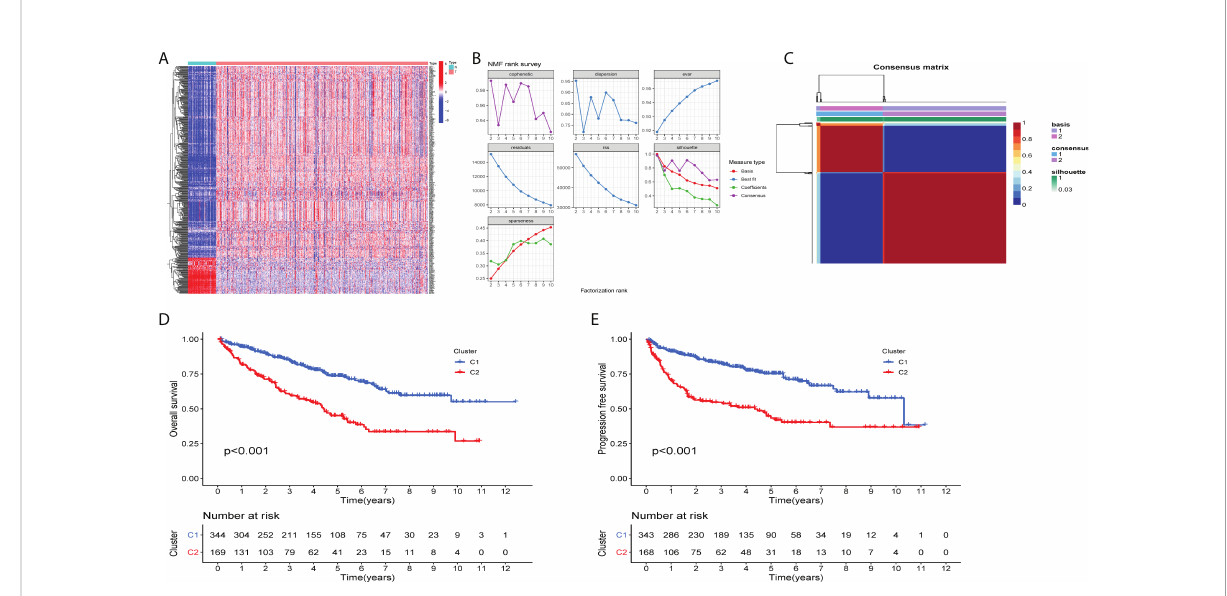
FIGURE 1 Two distinct TME-related molecular subtypes were identi fi ed by NMF analysis for ccRCC (A) The heatmap displays the expression patterns of TME-related genes in the tumors and normal tissues. N is equal to normal tissues, T is equal to tumor tissues. (B) Factorization rank for k = 2 – 10. (C) The heatmap of the consensus matrix when the consensus clustering k = 2. The value range is 0 – 1. The columns and rows are sorted through hierarchical clustering according to the Euclidean distance of the average link. (D) Kaplan – Meier OS curves and (E) PFS curve for the two clusters in TCGA-ccRCC dataset. The assessment of difference was achieved by log-rank